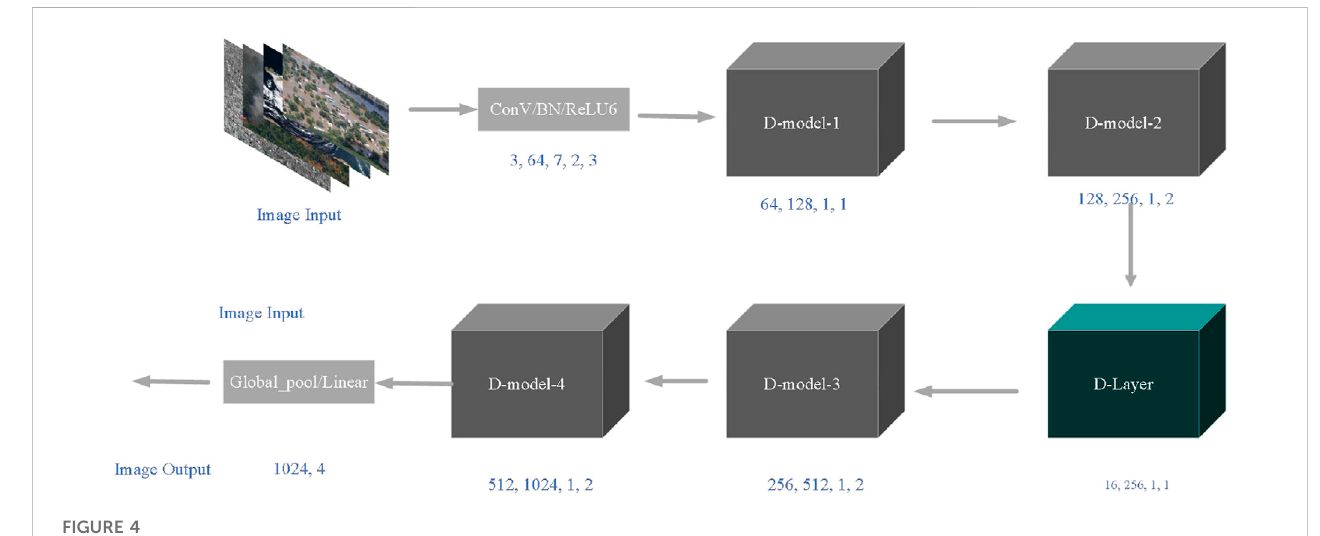
FIGURE 4 D-Net visualization network structure diagram.